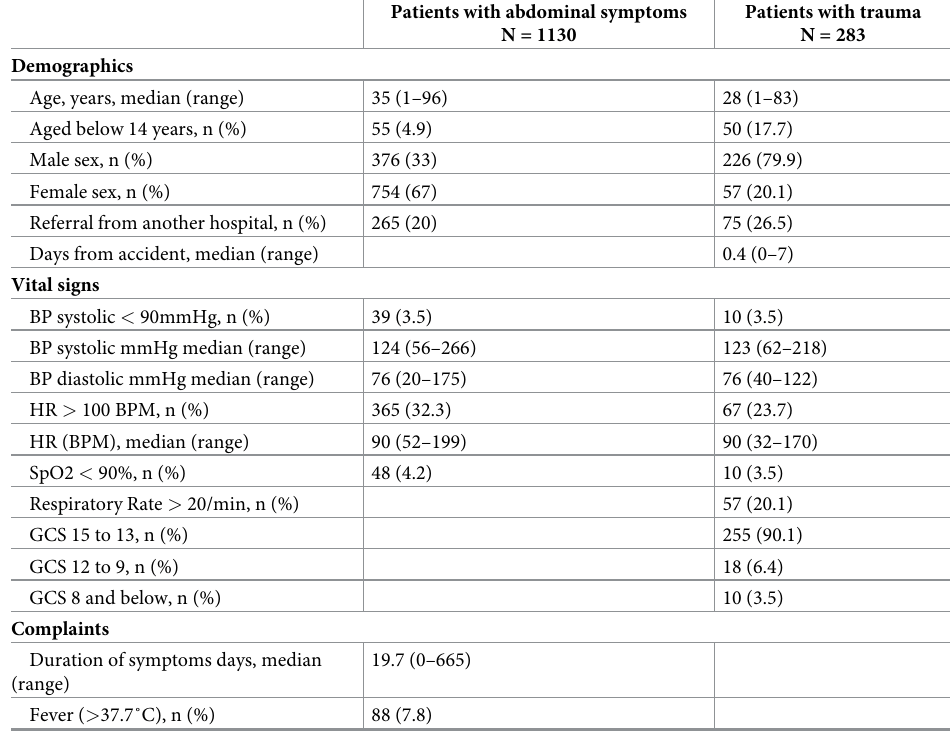
Table 2. Characteristics of 1130 patients who received abdominal ultrasound and 283 patients who received